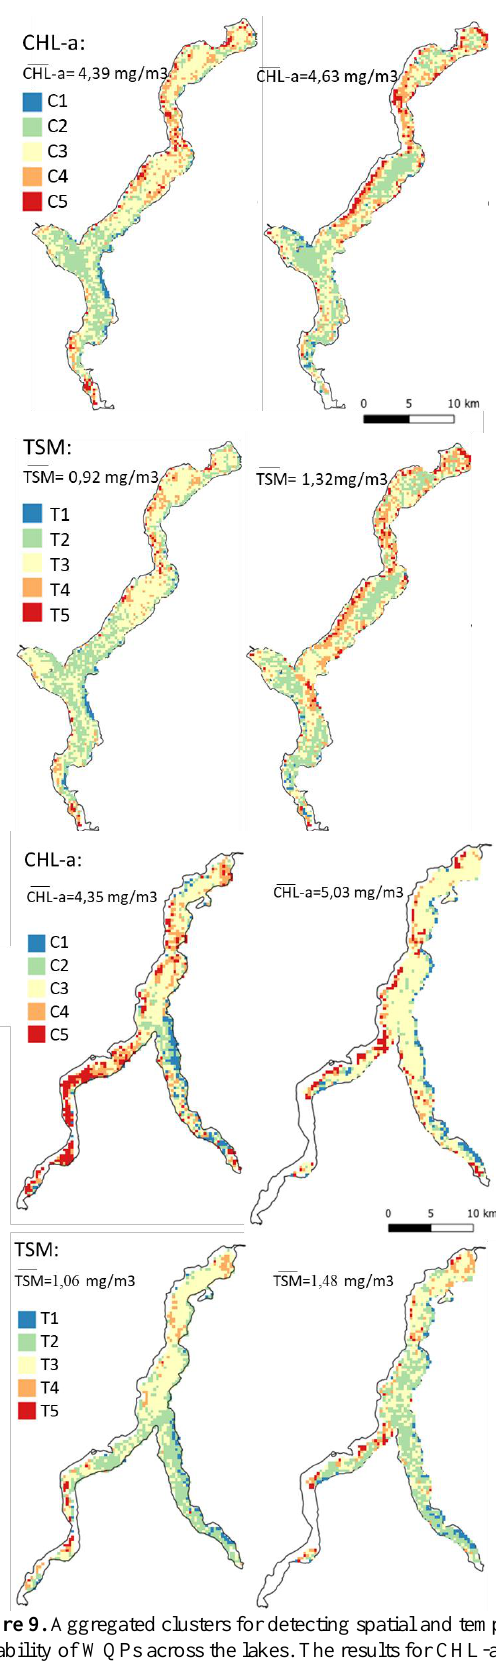
Figure 9. Aggregated clusters for detecting spatial and temporal variability of WQPs across the lakes. The results for CHL-a and TSM within lakes Maggiore and Como